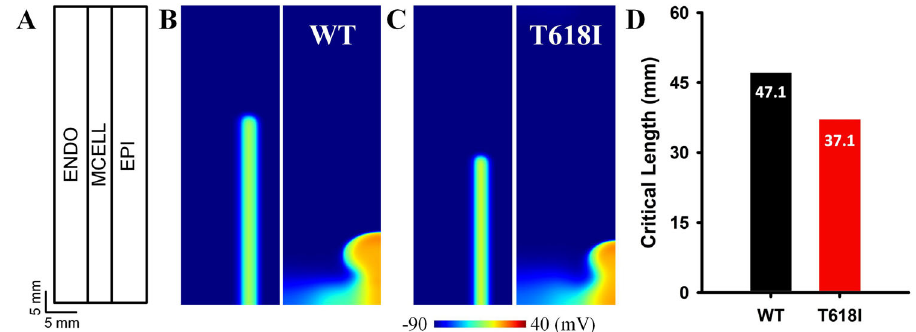
Fig. 4 Simulation results of the critical length in the idealized 2D sheet. A The schematic diagram of the idealized 2D sheet. B The critical length of S2 for initiating spiral waves in the wild-type tissue. C The critical length in the T618I mutant tissue. D The comparison of critical length in the two